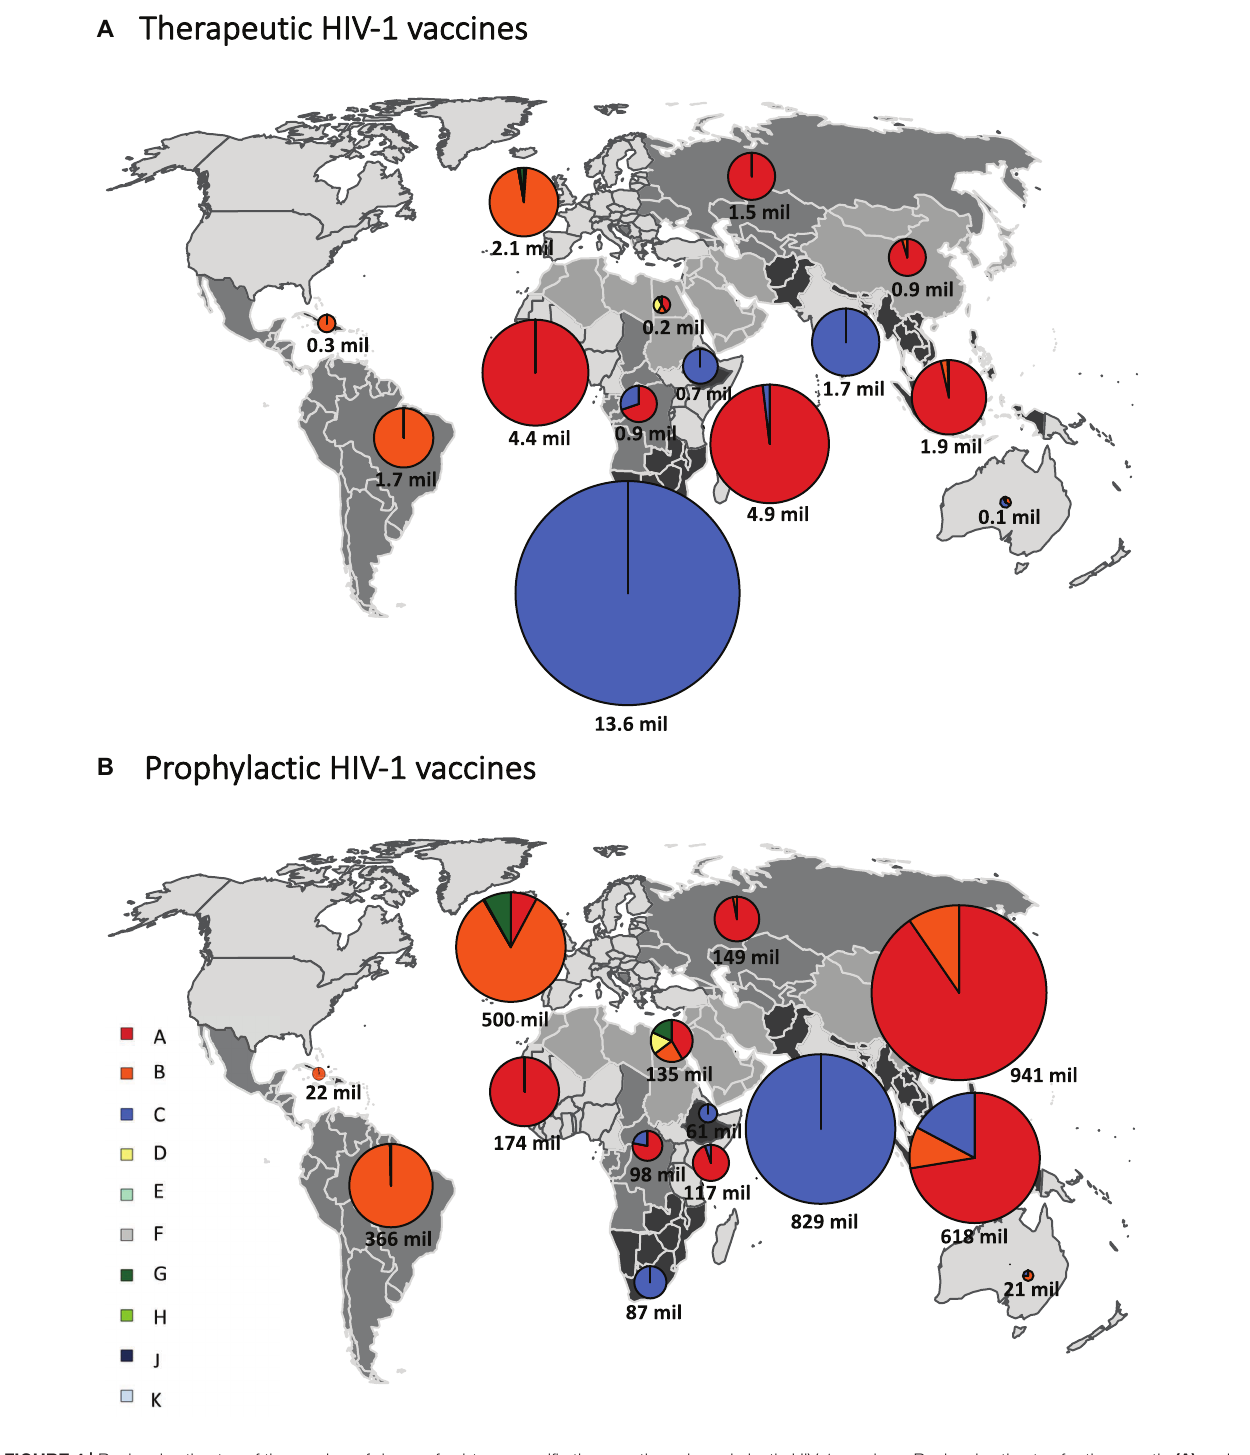
Frontiers in Microbiology |